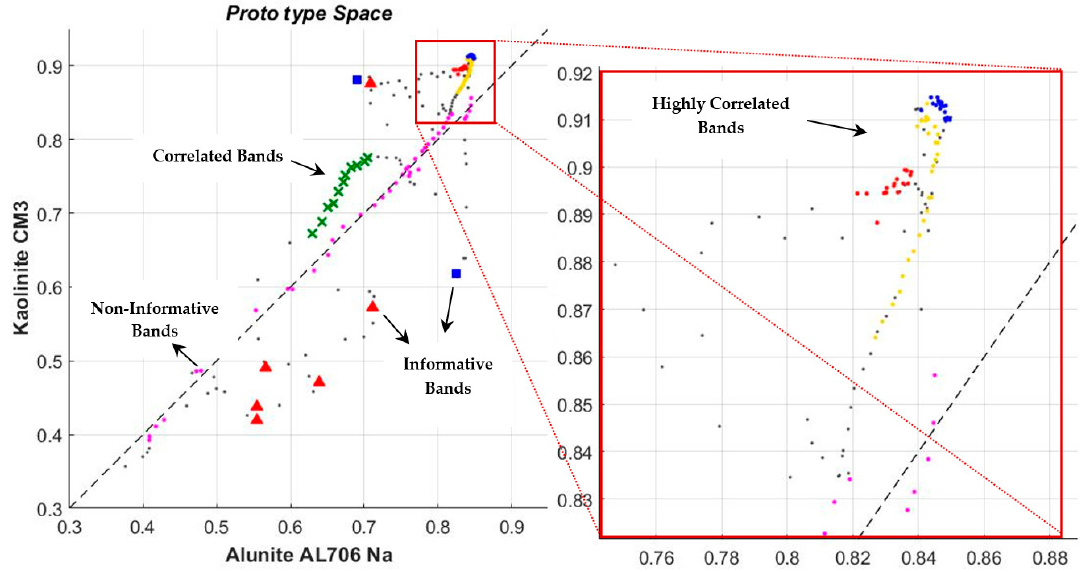
Figure 3. The Prototype Space (PS) constructed using the two endmembers alunite and kaolinite.